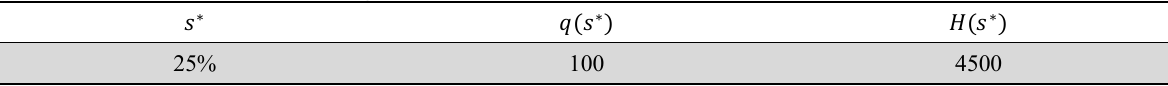
Solutions of traditional revenue-sharing contract